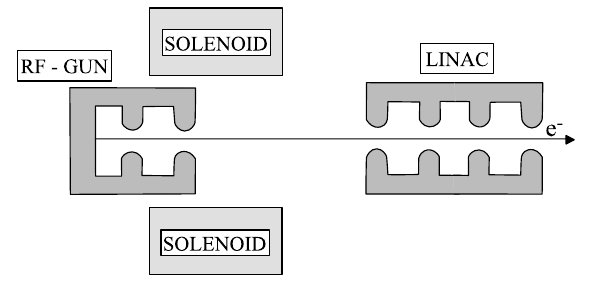
FIG. 2. Typical layout of an